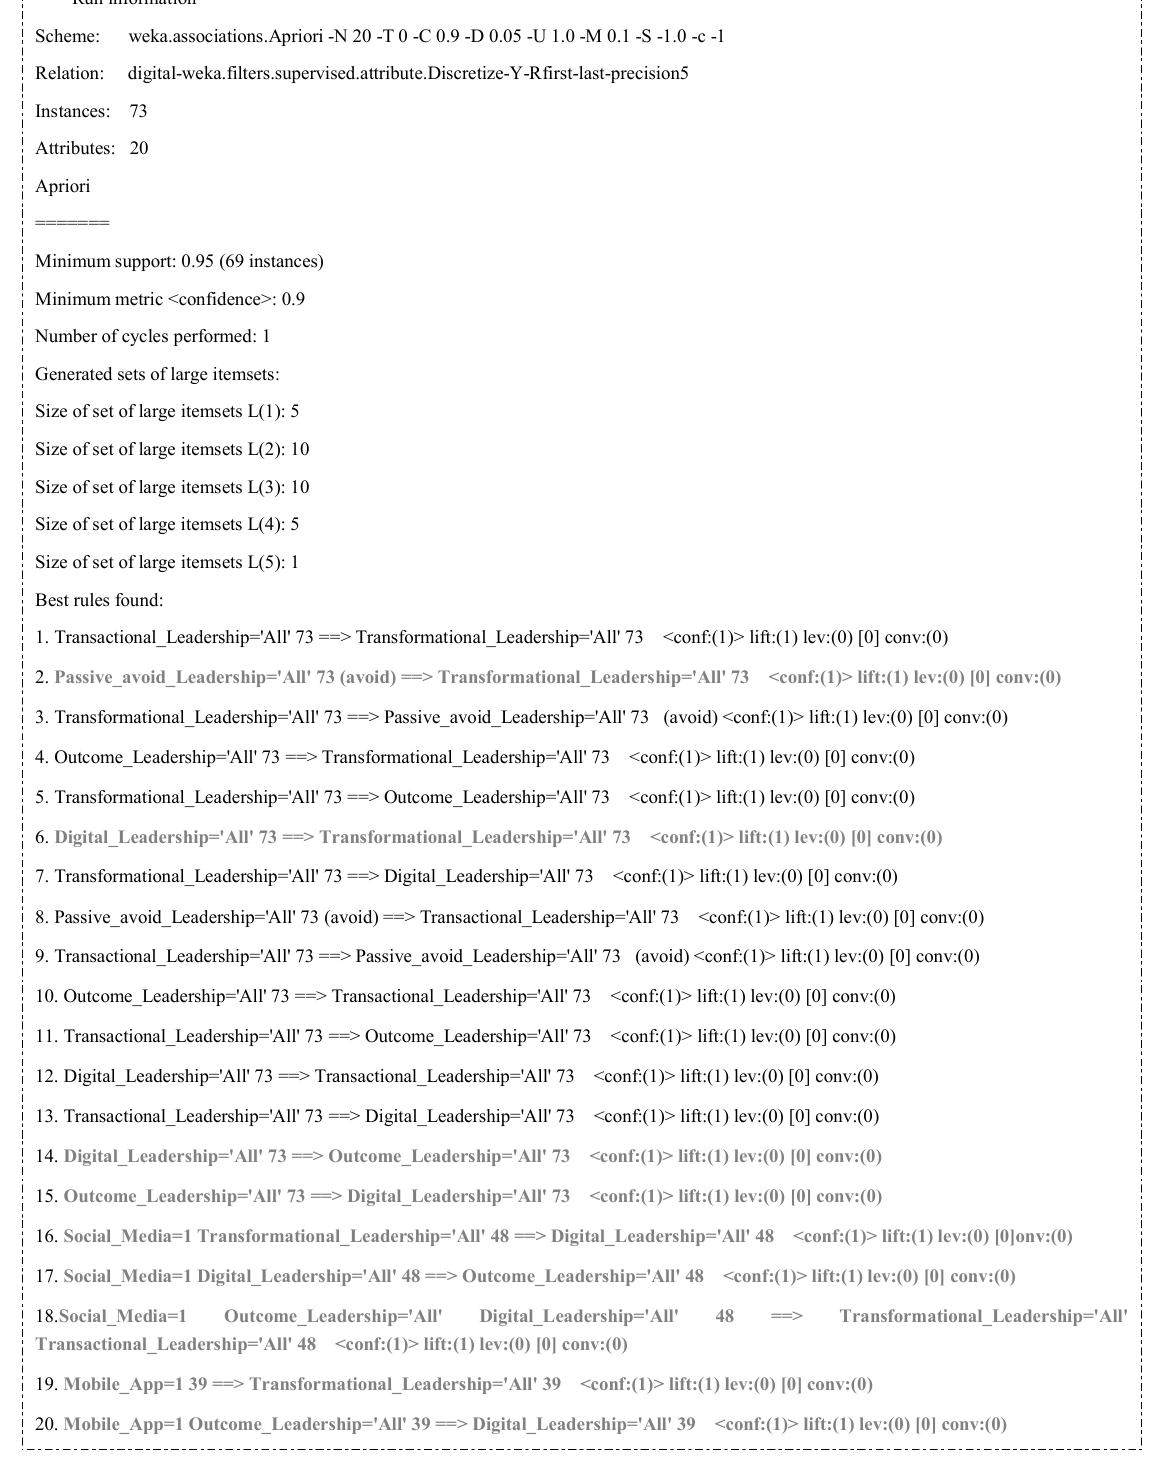
Table 25. Twenty (20) Best Apriori